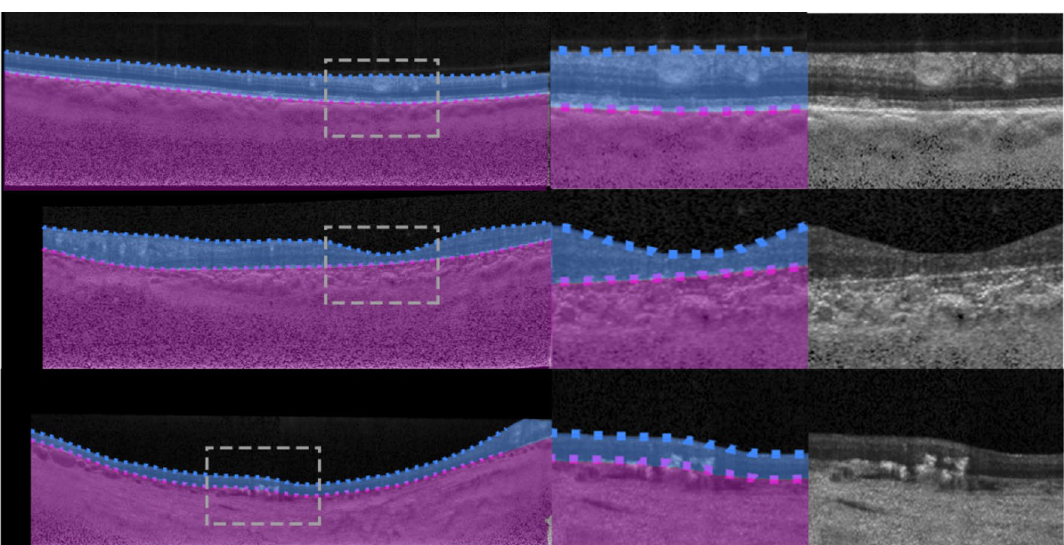
Figure 5. Example segmentation outputs from the R2 U-Net (3 layer variant) for the Stargardt disease dataset overlaid on the images. Left: full image with grey dashed rectangle corresponding to the zoomed area of the two rightmost images. Blue region: retina, purple region: choroid + sclera. Dotted lines correspond to the boundary position ground